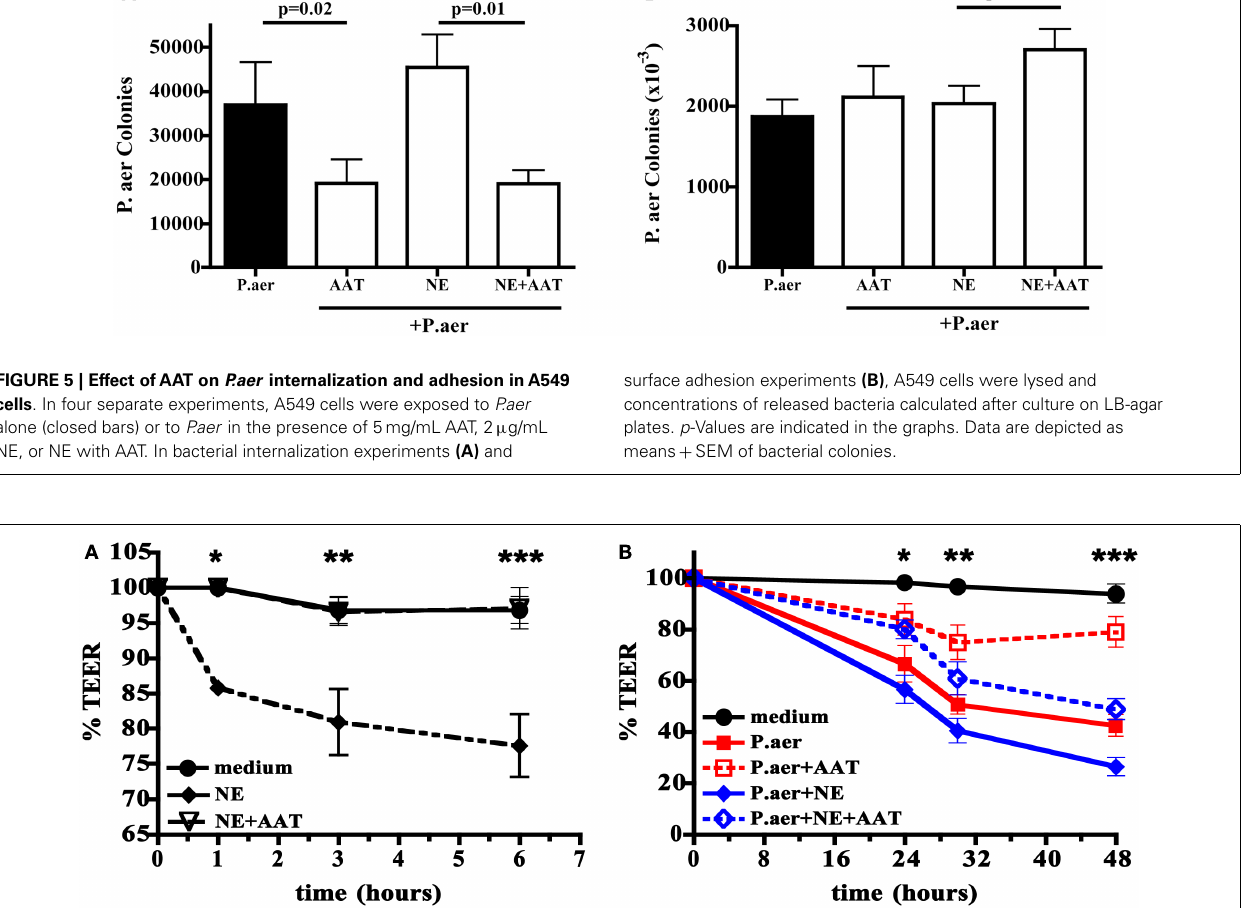
FIGURE 6 | Effect ofAAT on human NE- or P.aer -induced disruption of A549 cell monolayers . In (A) A549 cell monolayers were incubated with medium alone (medium, closed circles with solid line), human NE alone (NE, closed diamonds with dashed line), or with human NE in the presence of 5mg/mL AAT (NE + AAT, open triangles with dashed line). Data are expressed as percent ofTEER determined just prior to addition of NE (defined as T = 0 and set to 100%).The means ± SEM are shown for four separate experiments. * For T = 1h, significant differences were noted for NE compared to medium ( p < 0.001) and for NE compared to NE + AAT ( p < 0.001). ** For T = 3h, significant differences were noted for NE compared to medium ( p < 0.05) and for NE compared to NE + AAT ( p < 0.05). *** For T = 6h, significant differences were noted for NE compared to medium ( p < 0.001) and for NE compared to NE + AAT ( p < 0.001). In (B) A549 cell monolayers were exposed to medium alone (medium, black closed circles with solid line), P.aer alone ( P.aer , red closed squares with solid line), P.aer